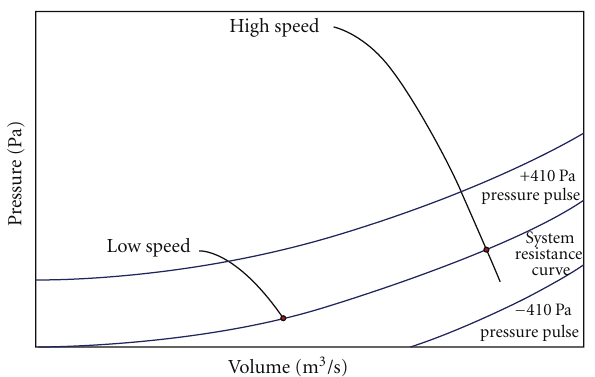
Figure 2: Fan performance under a pressure pulse at full and part